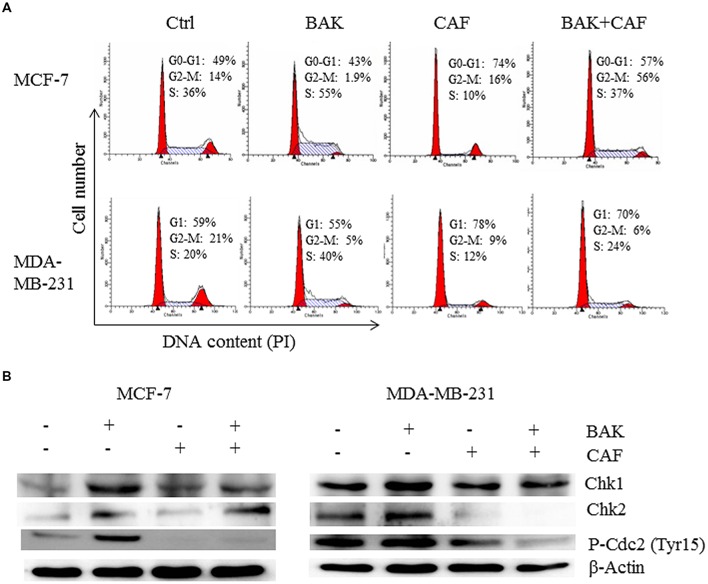
Caffeine rescued bakuchiol-induced S phase arrest in breast cancer cells. Cells were treated with ethanol alone or 7 μg/ml of bakuchiol and/or 5 mM of caffeine for 24 h. (A) representative cell cycle histograms from three individual experiments of control and treatment with percentage of cell cycle phase indicated. (B) Western blot analysis of Chk1, Chk2, P-Cdc2 (Tyr15) in total cell lysates. β-Actin was used as loading control. Ctrl, control; BAK, bakuchiol, CAF, caffeine.